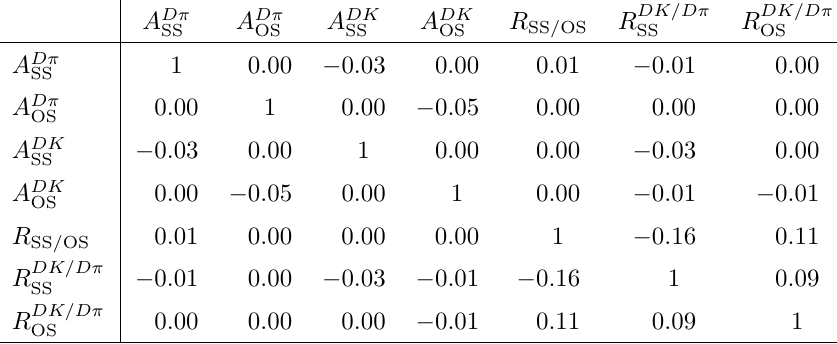
Table 6 . Statistical correlation matrix for the non